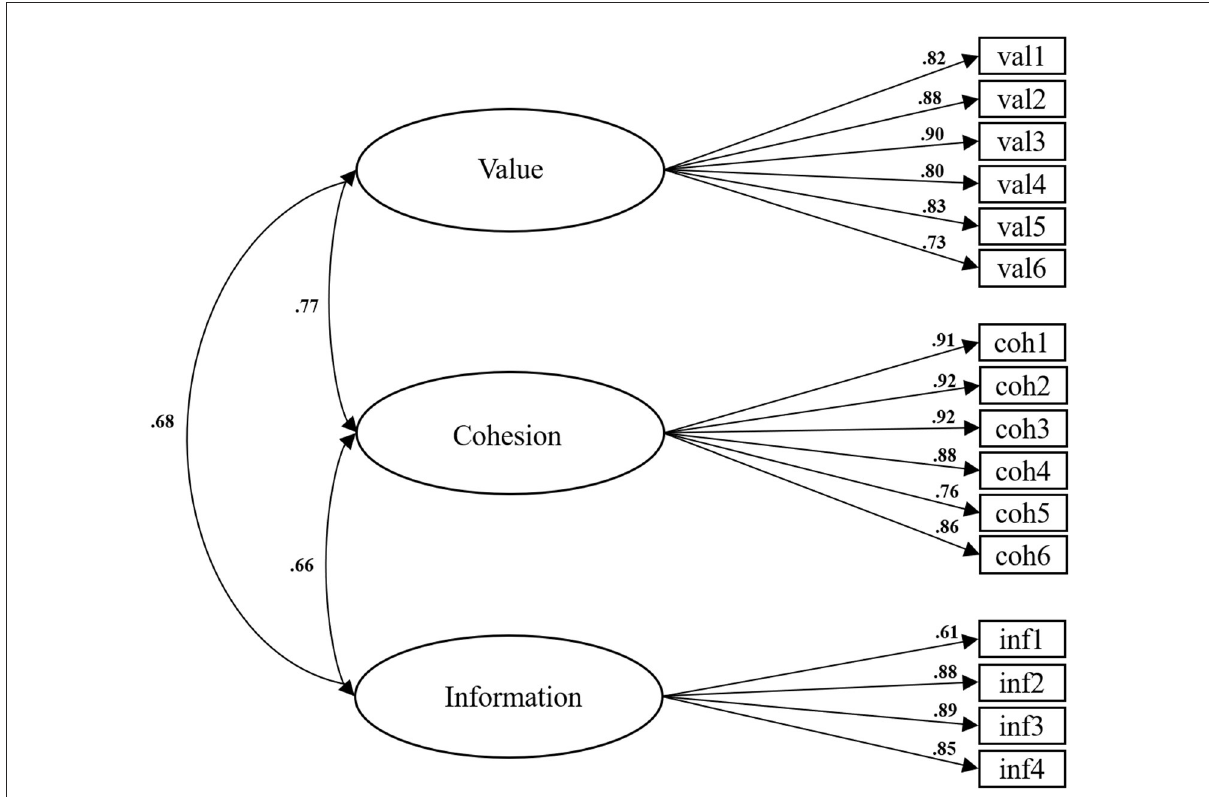
FIGURE1 FHC-PA (Sg) standardized factor loadings and inter-factor correlations.